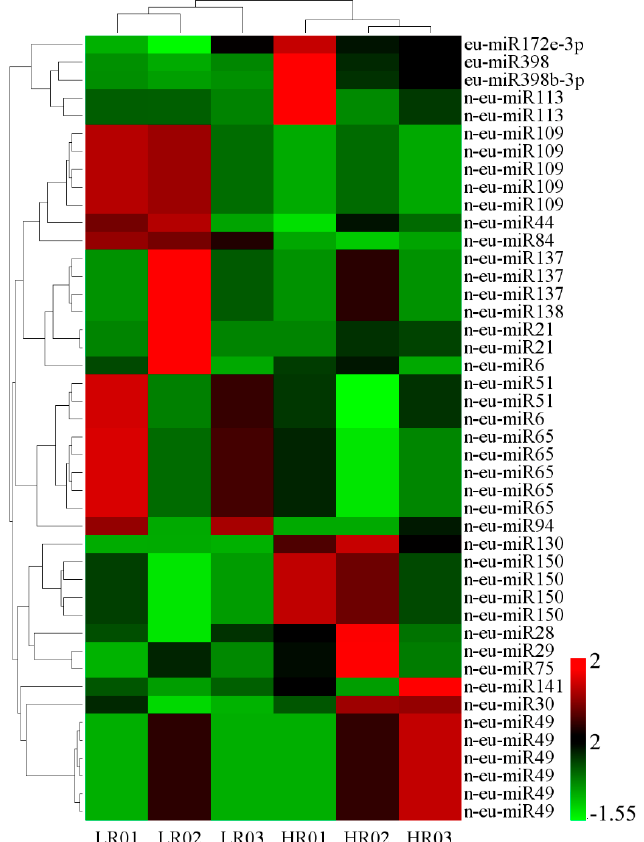
Figure 3. Eucommia rubber (Eu-rubber) biosynthesis-related miRNAs in E. ulmoides . Differentially expressed miRNAs (DEM) in LR (low Eu-rubber content) and HR (high Eu-rubber content) libraries by hierarchical clustering. Red indicates a high expression level and green indicates a low expression level. The original expression values of miRNAs were normalized using Z-score normalization.